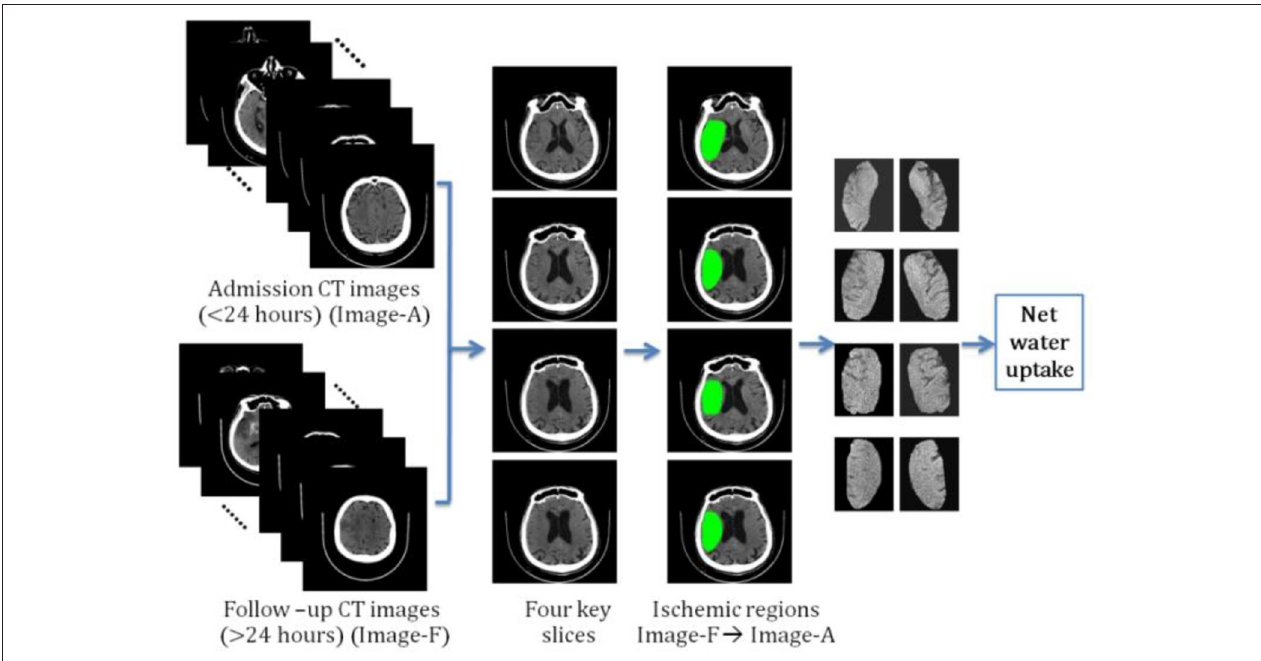
FIGURE 2 | The procedure for calculating segmented region-based net water uptake (SR-NWU).